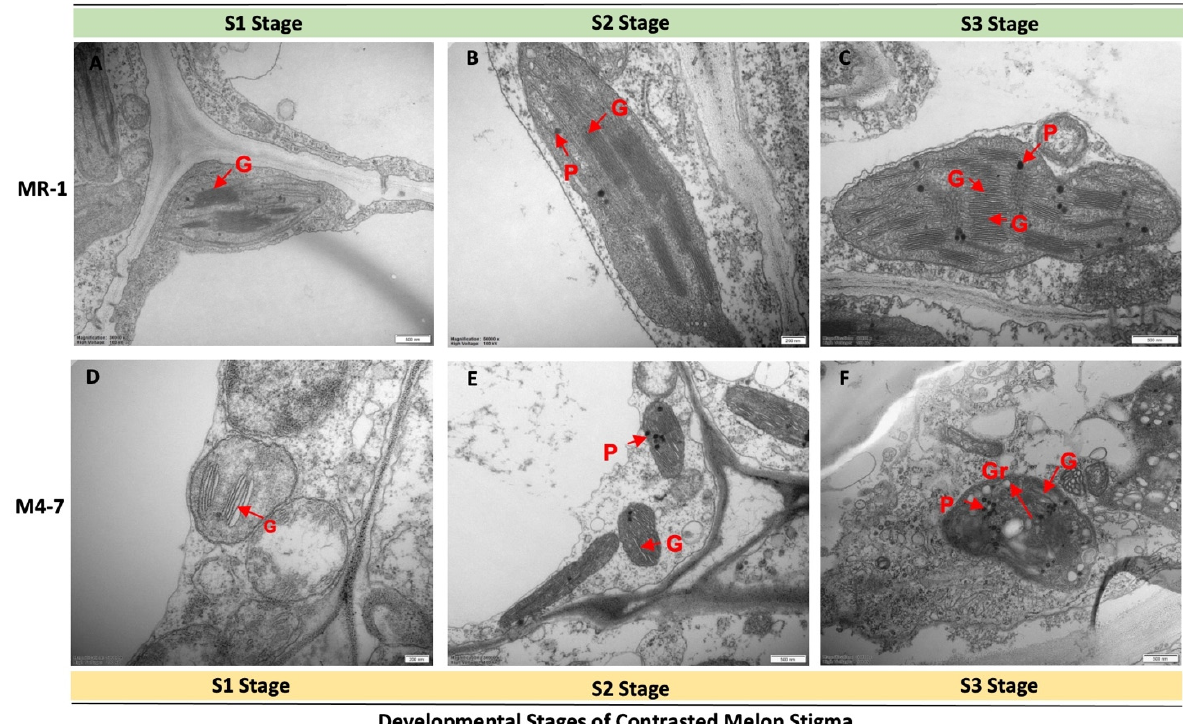
Figure 3. Primary differentiation in chloroplast ultrastructure of the two contrasted melon lines during three developmental stages (S1, S2, and S3). ( A – C ) The structural variation in the chloroplast of the MR-1 line and ( D – F ) the M4-7 line. G: granum; P: plastoglobulus; Gr: starch grains.